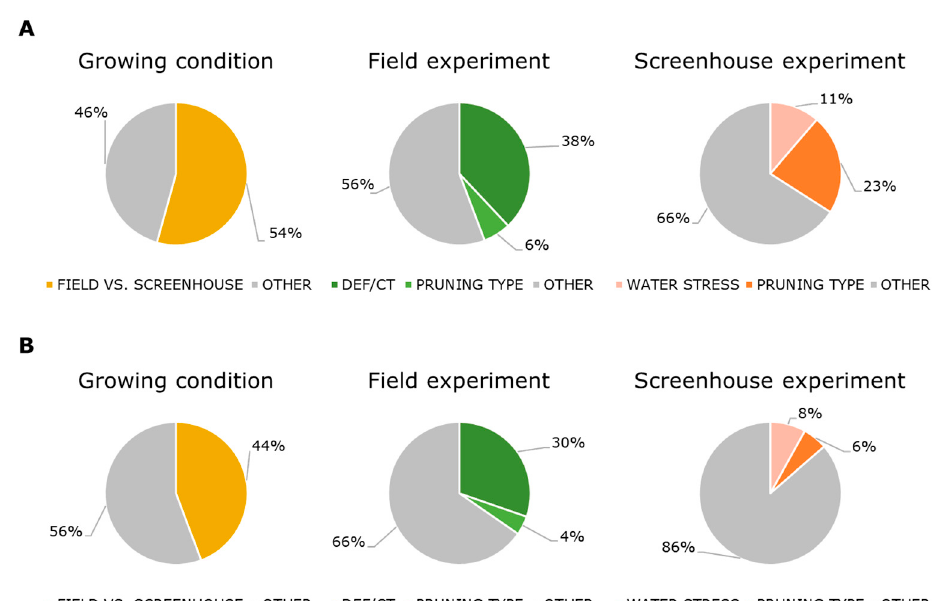
Figure 6. ASCA performed on the NMR metabolite concentrations from must ( A ) and wine ( B ) samples from the field and screenhouse experiments. Each experimental factor is represented with a slice in the chart. Effect sizes (%) are given next to the slices. All effects are significant ( p <0.001, 1000 permutations). Stress-related classes in the field (DEF/CT) experiment = control, DEF, CT, and DCT; Stress-related classes in the screenhouse (water deficit) experiment = control, early-stress, mid-stress, and late-stress. Grey areas represent the residual and unknown source of variability.